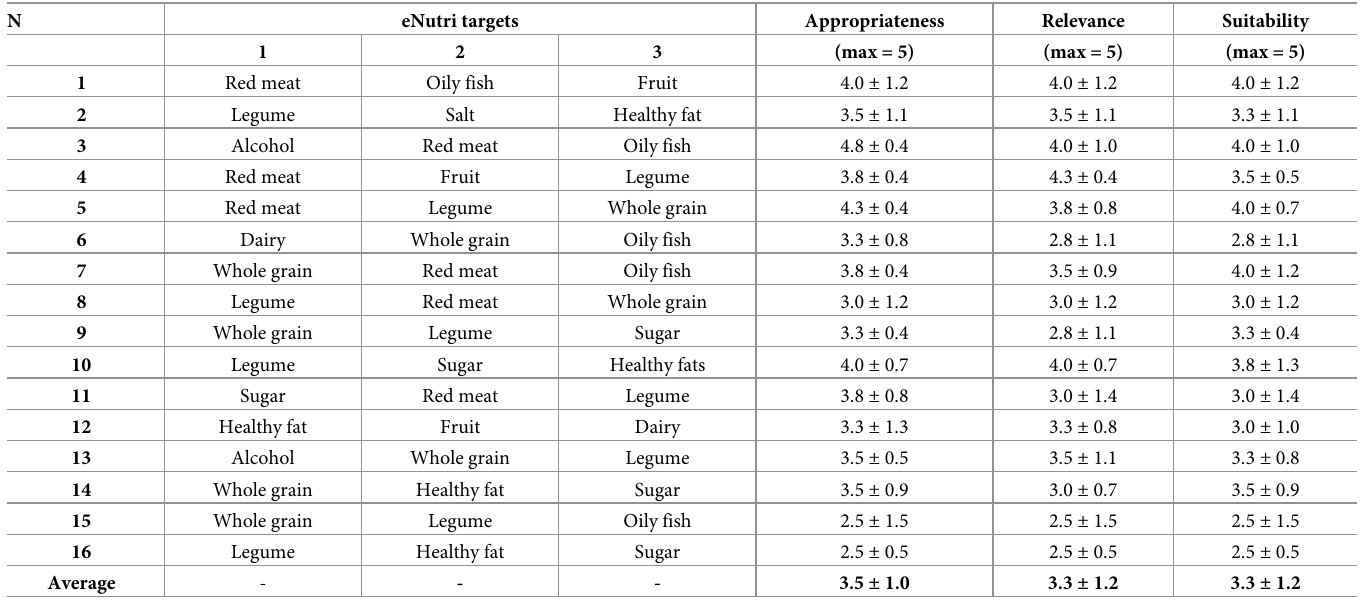
Table 3. Professional evaluation of eNutri automated personalized nutrition advice according to scenarios (n = 4 responses per scenario).